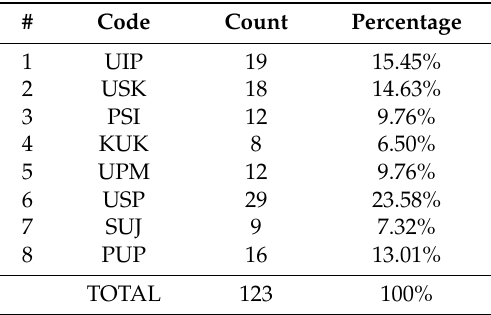
Table 1. LIS schools and percentage of responses.